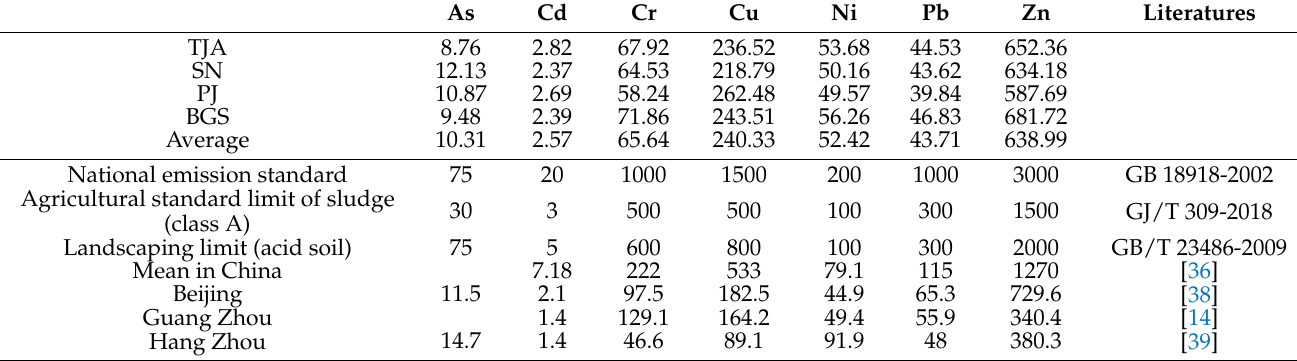
Table 4. Comparison of the heavy metal contents in municipal sludge from the literature